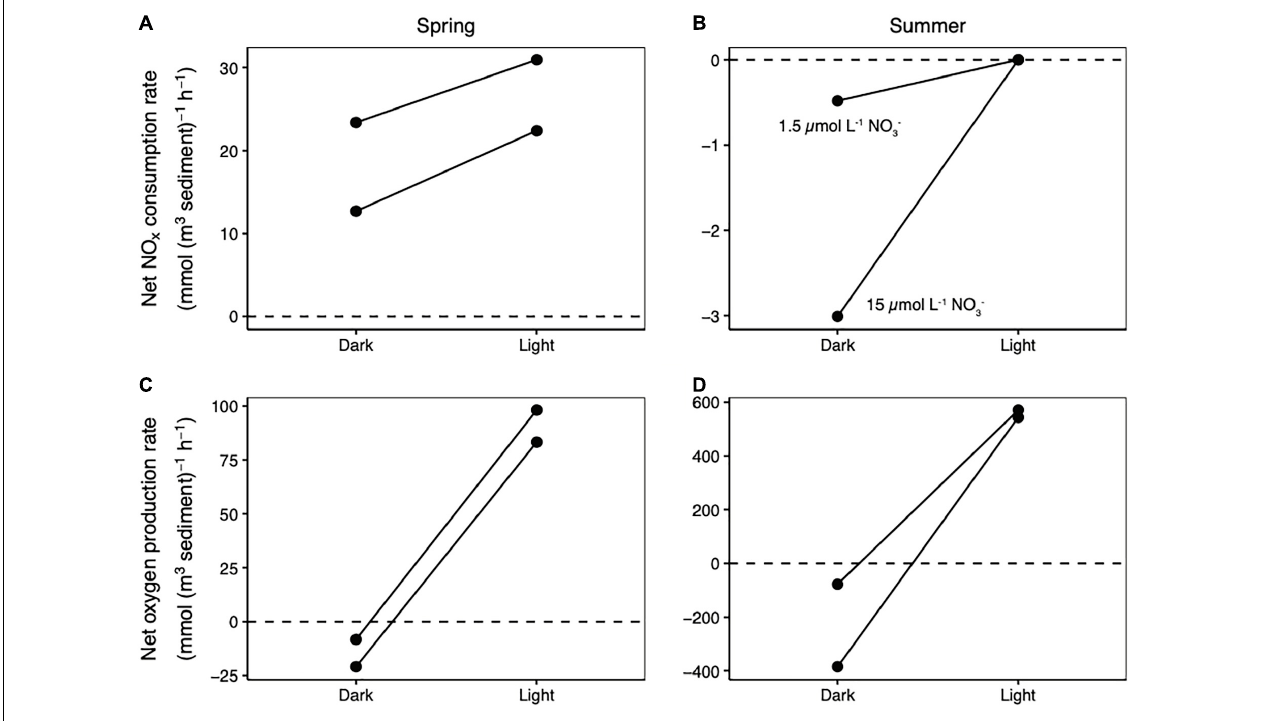
FIGURE 1 | Changes in net NO x consumption rates between dark and light conditions measured in the spring (A) and summer (B) . Changes in net oxygen production rates between dark and light conditions measured in the spring (C) and summer (D) . A line connects the dark and light measurements made on each core. Negative net consumption rates in (B) indicate net NO x